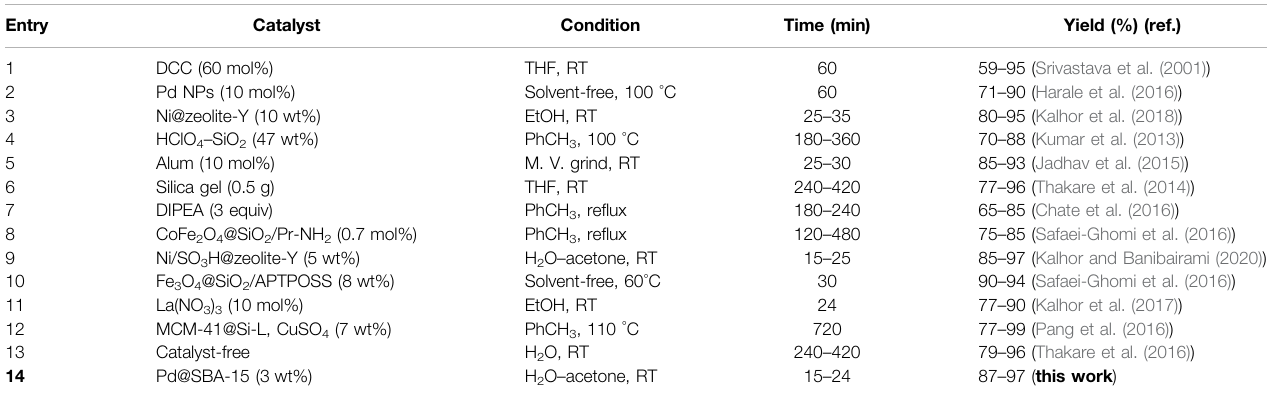
TABLE 4 | Comparison of the activity of various catalysts for the synthesis of 1,3-thiazolidin-4-ones. Entry Catalyst Condition Time (min) Yield (%) (ref.)